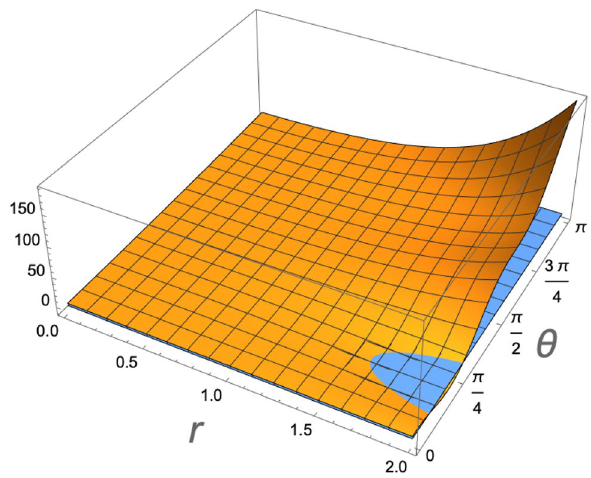
Figure 9. Entanglement of the ions logitudinal vibrational as a function of the squeezing parameter of ion 2, r , and the interaction θ = gt , at a heating rate Ŵ = 1.885 quanta per milisecond ( Ŵ/ g = 0.1936 ). The entanglement is severely affected by the heating as the global state becomes more